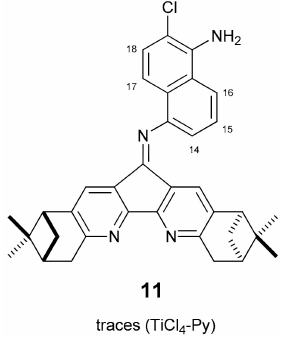
Figure 2. Chemical structure of the by-product in the condensation of dipinodiazafluorenone 1 with